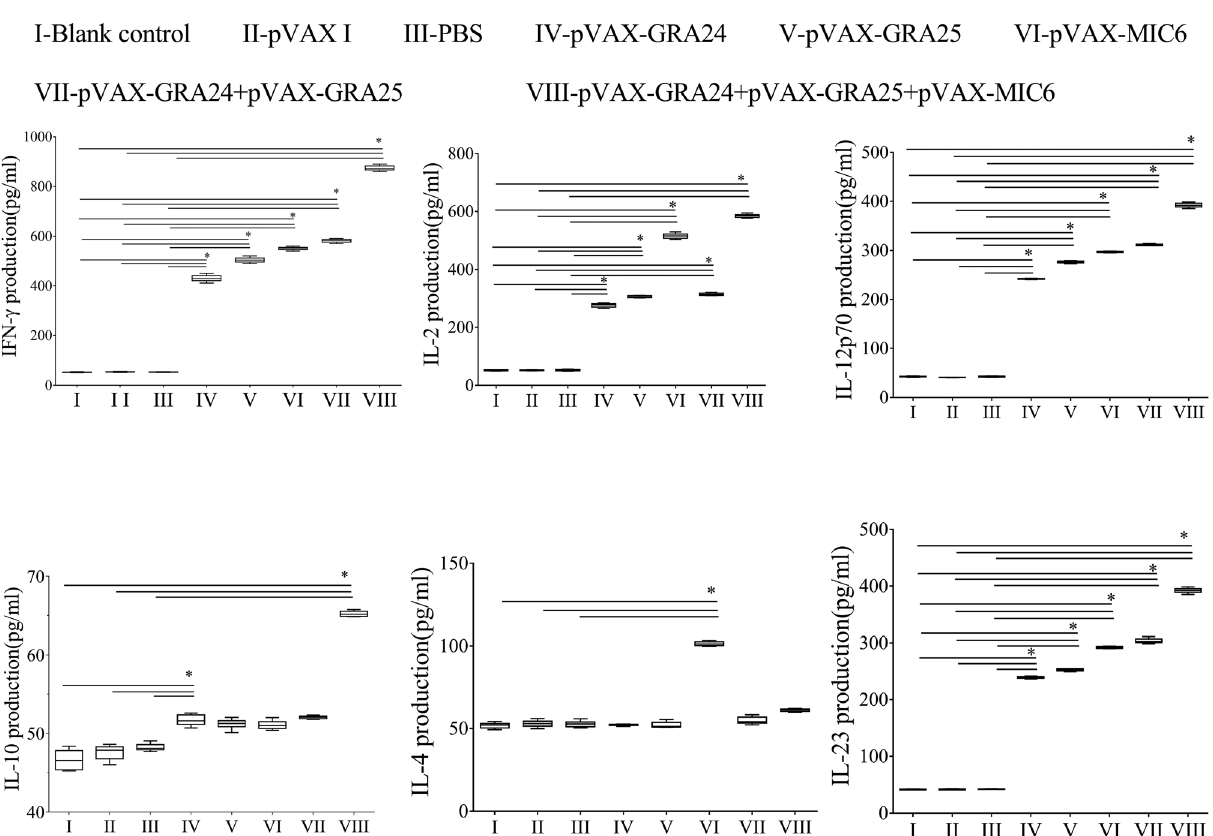
Figure 3. Cytokine production by splenocytes of mice immunized with single or multiple genes. * p <